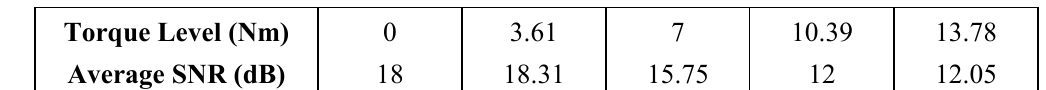
Table 1. Experimentally obtained signal to noise ratio (SNR) for different torque values applied to the bolted